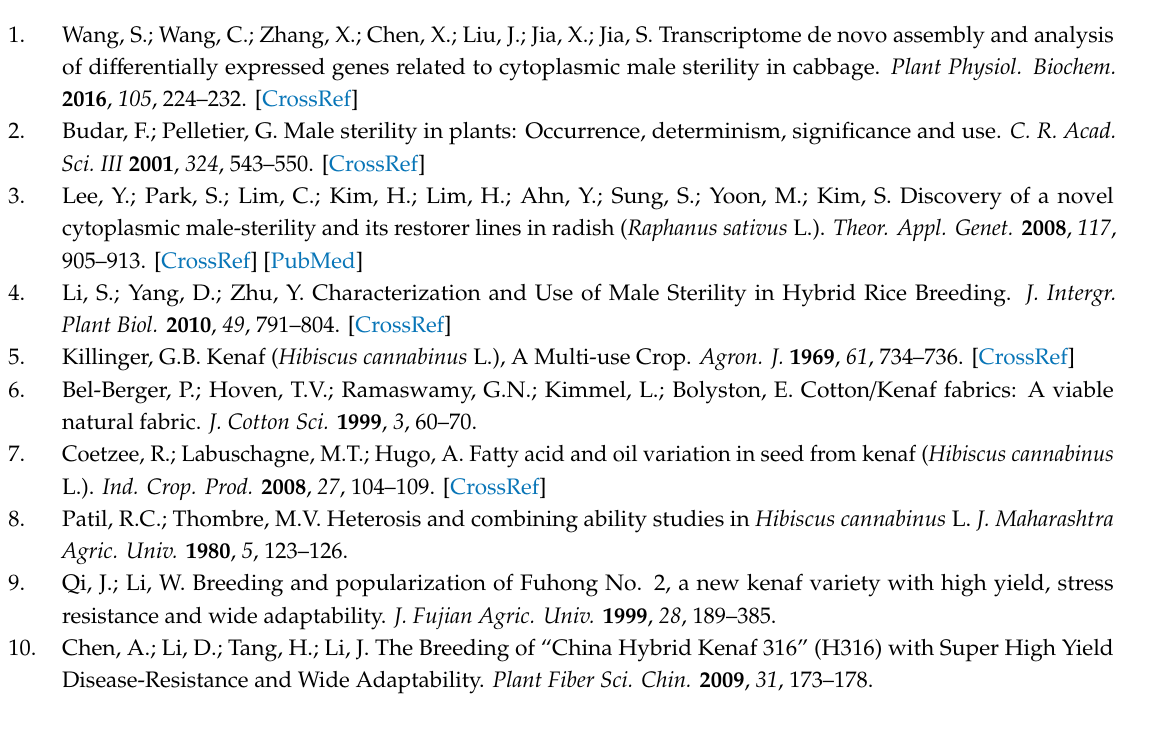
sample. Figure S3. Heat map of sample correlation based on gene expression